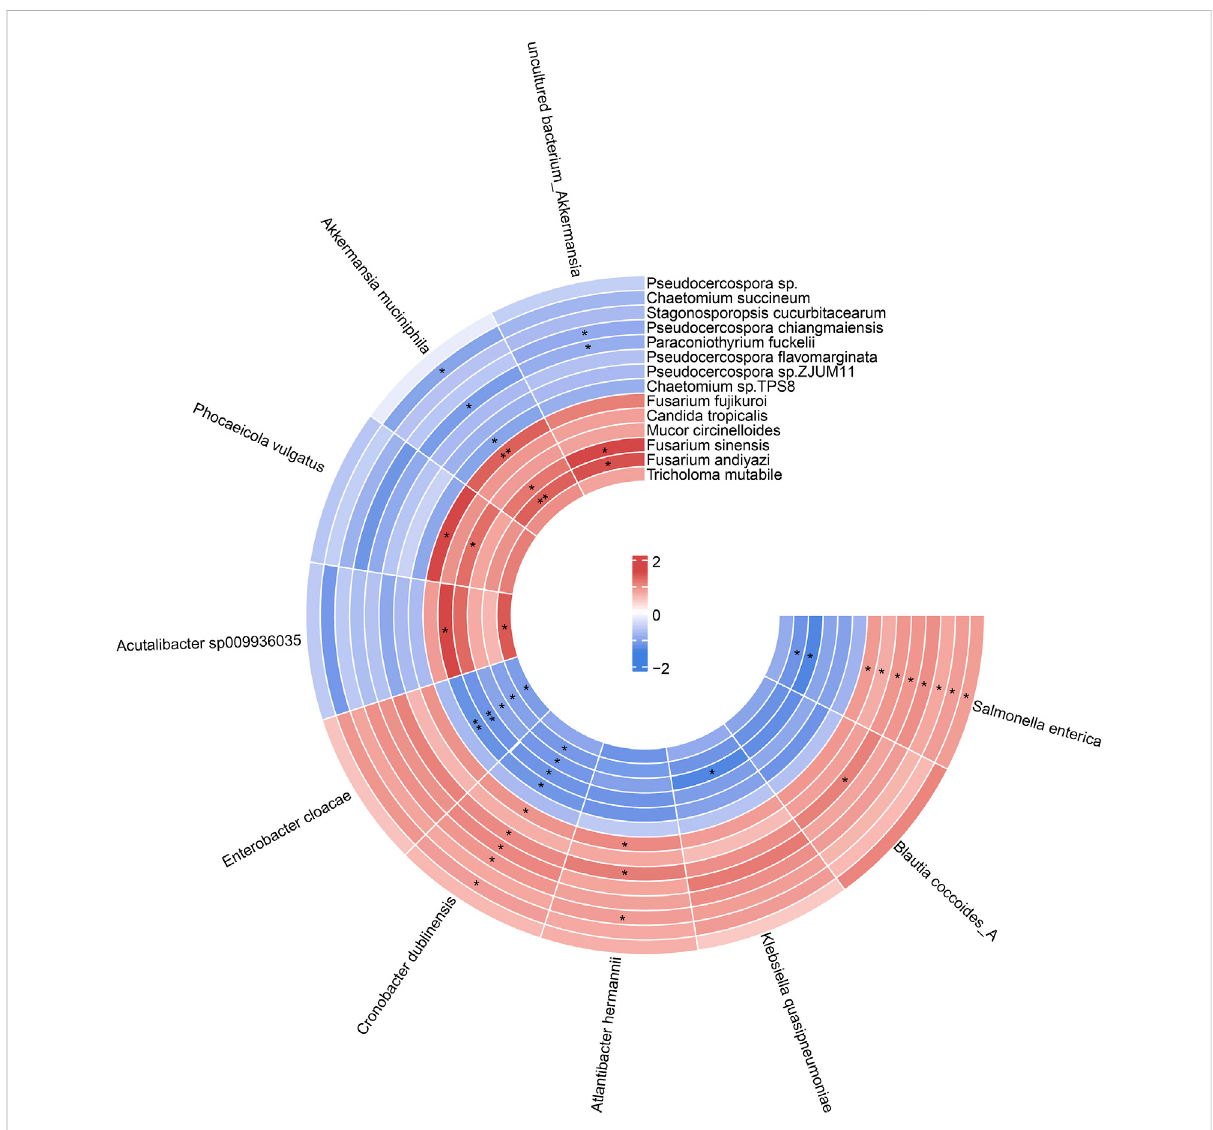
FIGURE 8 The circular heat map showed the correlation between differential species of gut fungi and gut bacteria. p value was adjusted by FDR. * P adj < 0.05, ** P adj < 0.01.